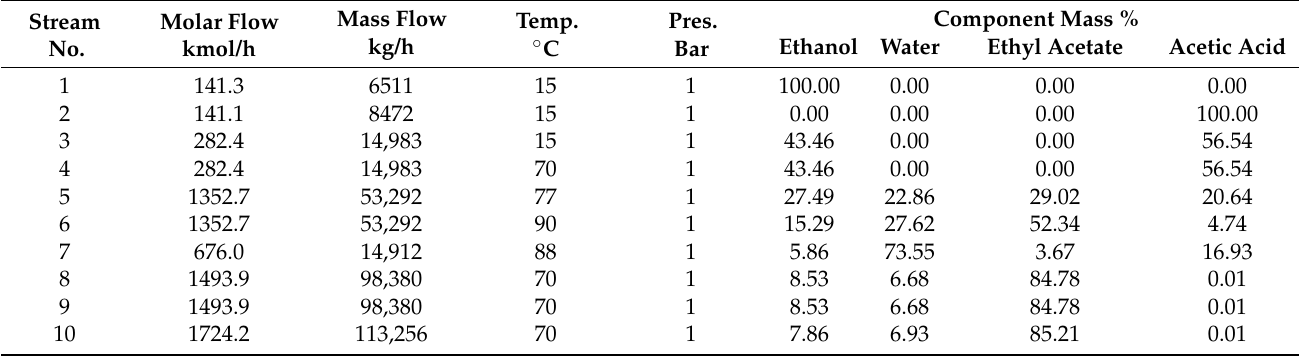
Table A2. Mass balance of the typical installation to produce EA, strategy 2